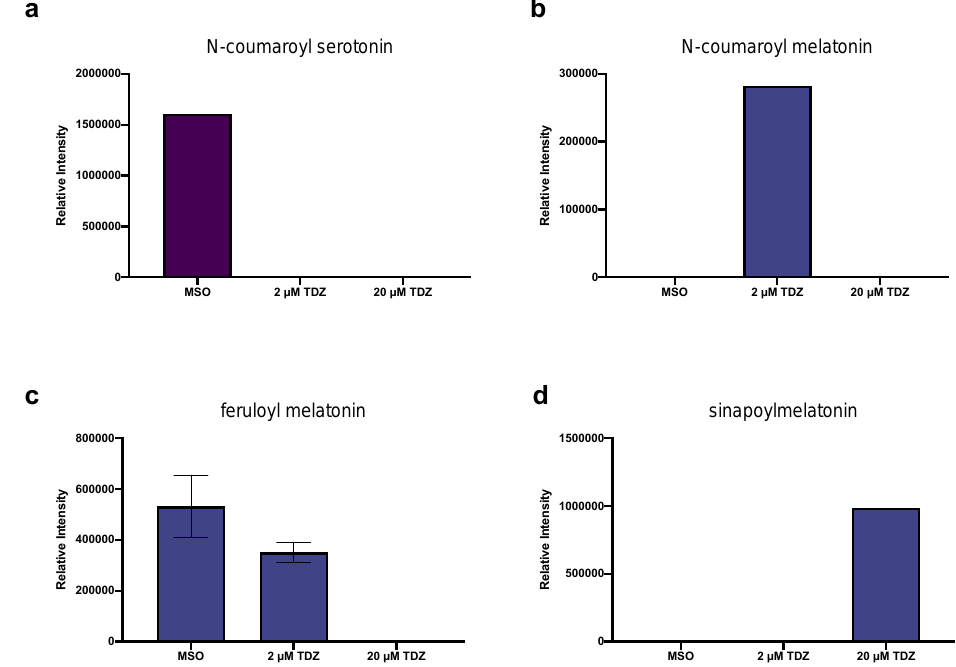
Figure 8. E ff ects of thidiazuron (TDZ) exposure on proposed indoleamine (serotonin (5HT) and melatonin (MEL)) phenolic conjugates in African violet petioles. Purple denotes 5HT conjugates ( a ), blue MEL conjugates ( b – d ). Bars represent mean, error bars span standard error margin. Where no error bars are displayed, the feature was present in only one